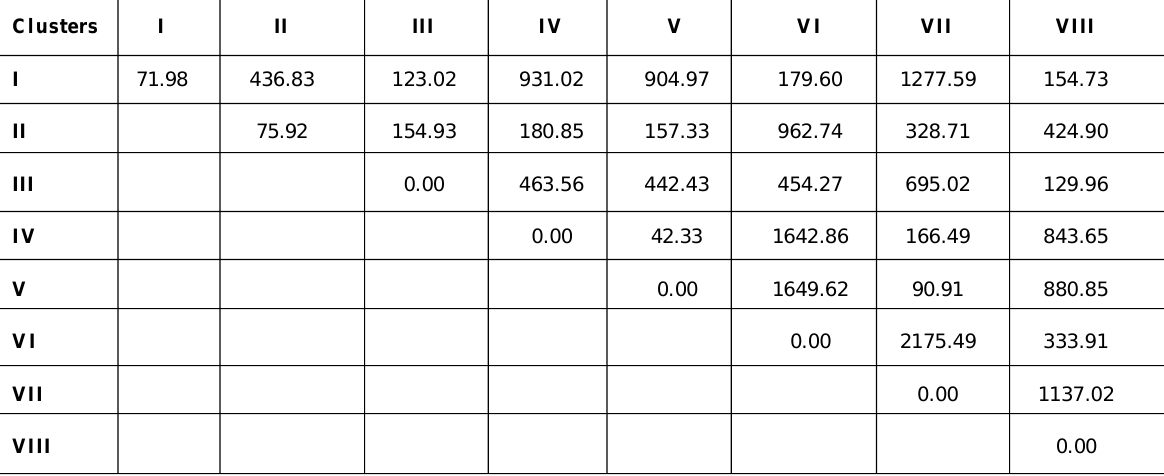
Table 7: Average intra and inter cluster divergence for quantitative traits